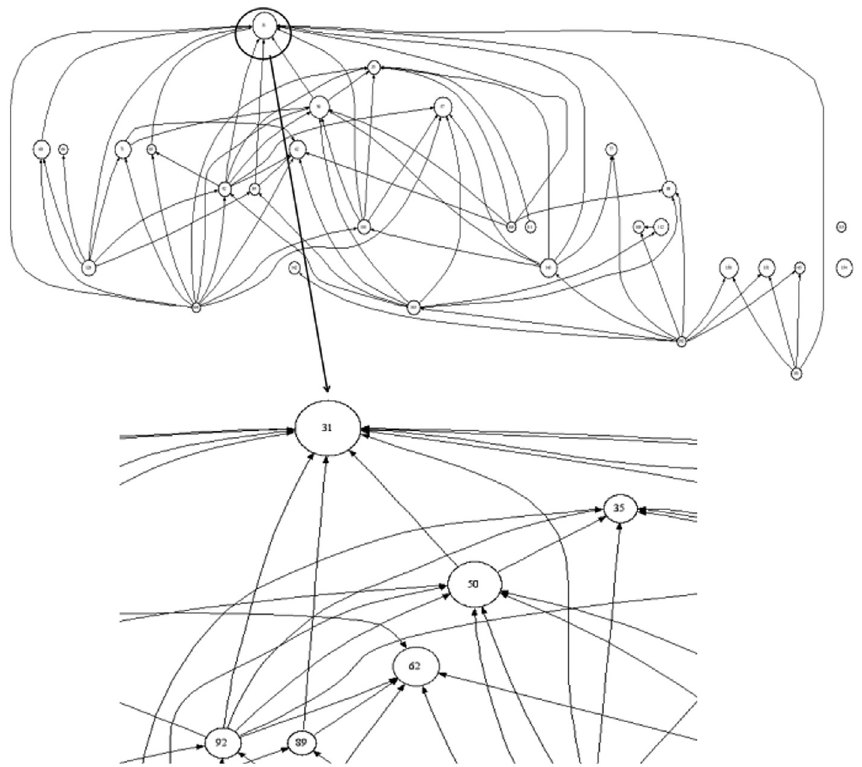
Figure 2. CF citation chronological chart ( n